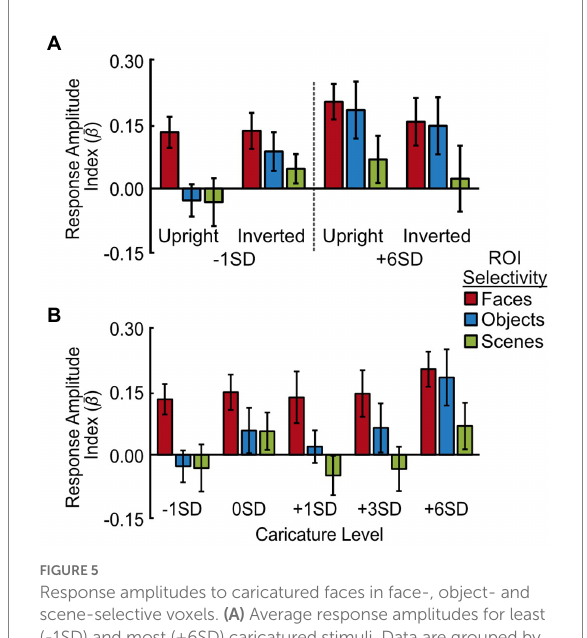
FIGURE 5 Response amplitudes to caricatured faces in face-, object- and scene-selective voxels. (A) Average response amplitudes for least (-1SD) and most (+6SD) caricatured stimuli. Data are grouped by image orientation (upright, inverted) and region of interest (face-, object-, and scene-selective voxels across hemispheres). (B) Average response amplitude to the 5 levels of caricatured, upright faces in face-selective (red), object-selective (blue) and scene-selective (green) voxels. As there was no interaction with hemisphere the response amplitudes are averaged across hemispheres. Y axes show the response amplitude index, measured by offsetting the β coefficients from the deconvolution analysis by t 0 , and averaging t 1-4 . Error bars show ± 1 SEM of the between-subjects